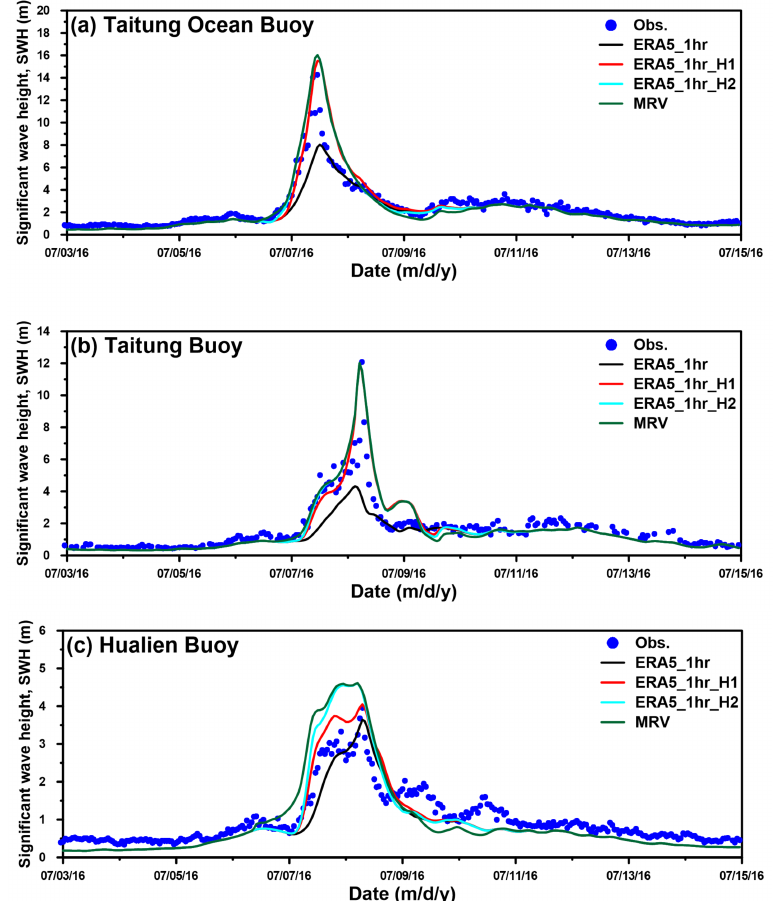
Figure 11. Model-data comparison for the SWH time series at the ( a ) Taitung Ocean, ( b ) Taitung, and ( c ) Hualien buoys employing the winds from ERA5_1hr, ERA5_1hr_H1, ERA5_1hr_H2, and modified Rankine vortex